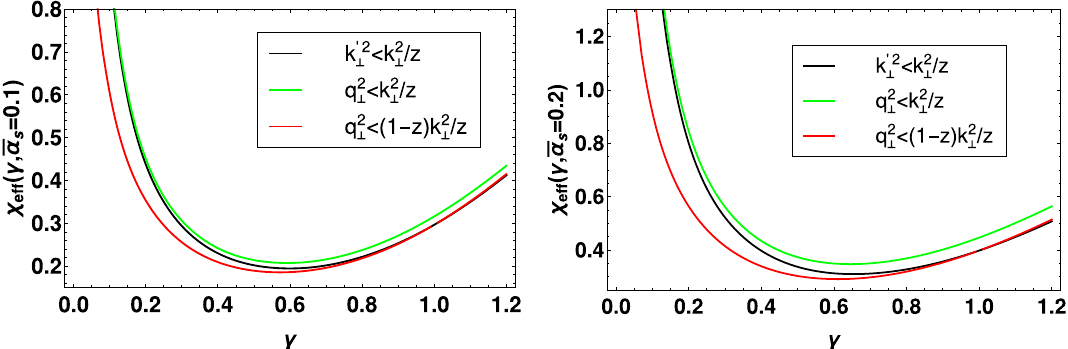
Fig. 2 The effective Mellin transformed kernel χ eff for the three different versions of the kinematical constraint (9), (10), (12) as a function of Mellin variable γ . Left: ¯ α s = 0 . 1, right plot ¯ α s = 0 . 2